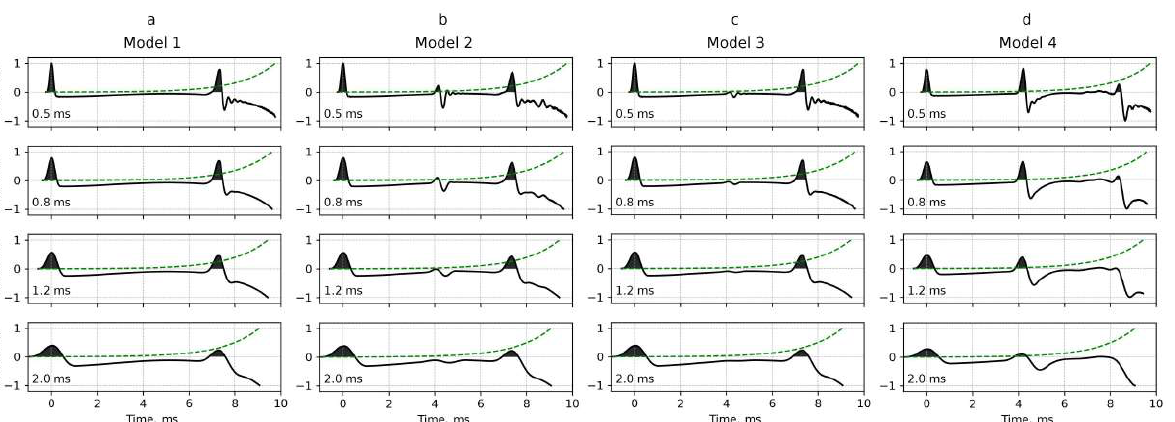
Figure 3. Results of numerical simulations of low strain integrity testing with input pulse forces of 0.5, 0.8, 1.2, and 2.0 ms calculated for the driven pile models: ( a ) single-section pile—Model 1; ( b ) 5 mm sand gap—Model 2; ( c ) 1 mm sand gap—Model 3; ( d ) 1 mm air gap—Model